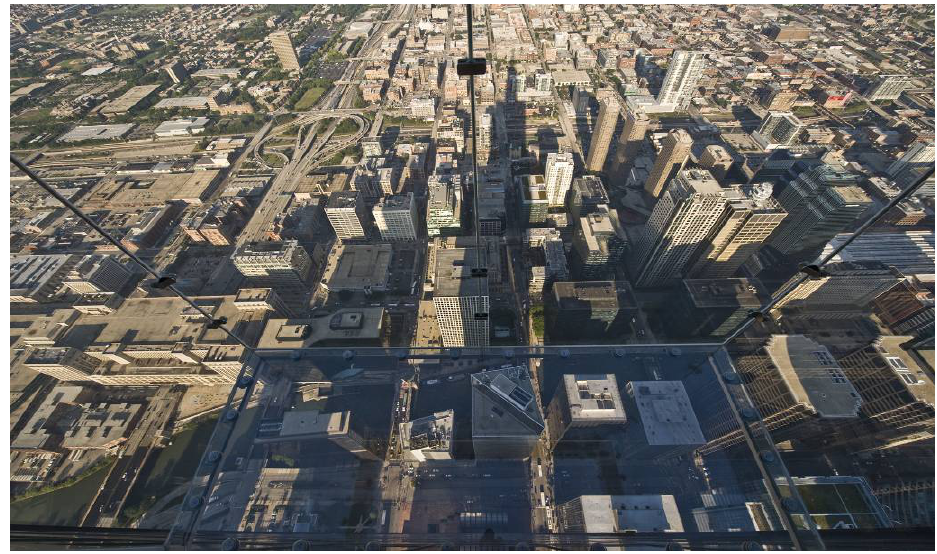
Figure 1: Completed Ledge Skybox looking West over the City of Chicago.